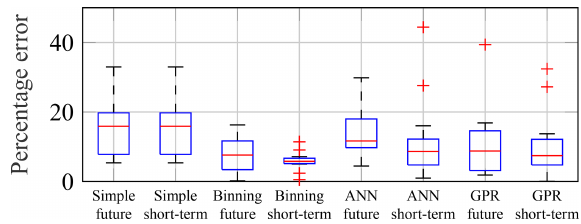
Figure 28. Percentage errors of predicted yearly damage values us- ing all extrapolation methods compared to real yearly damage val- ues. Results of predictions into the future using long-term EOC data are compared to previous results for which EOC data are available (short-term predictions of past periods); 13 different years are used in both